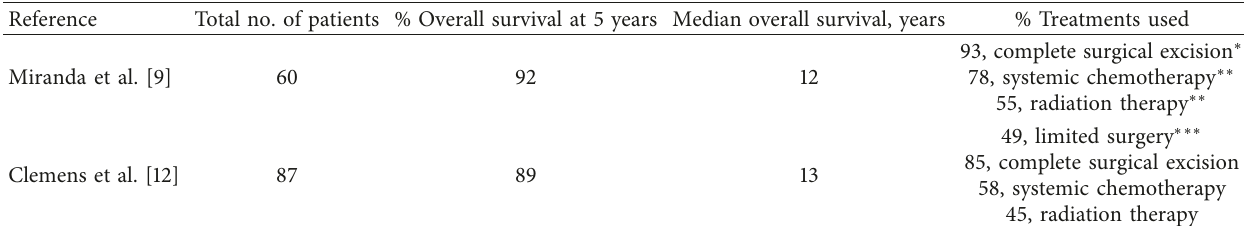
Figure 3: High power (40x) of horseshoe cells (cells with eccentric nuclei) with a mixed infiltrate in between, which are the “hallmarks cells” in anaplastic lymphoma (a), lymphoma/large cells shown diffusely positive for CD30 (b), and ALK shown diffusely negative throughout (c). Table 1: Summary of reported outcomes.